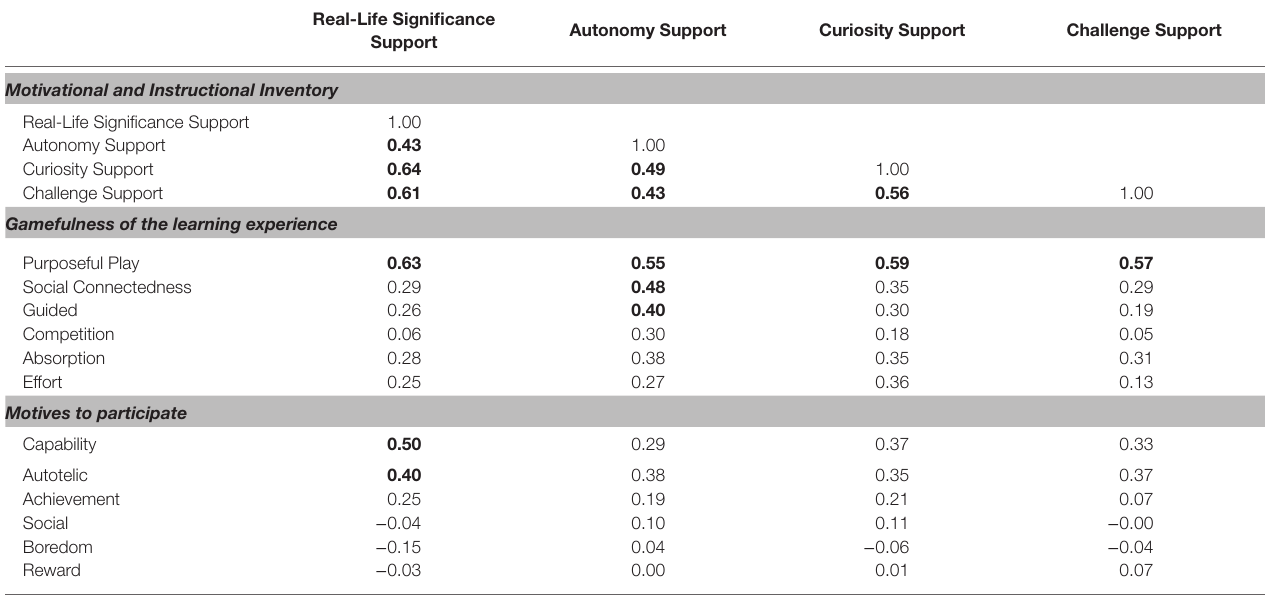
Correlations over 0.4 are